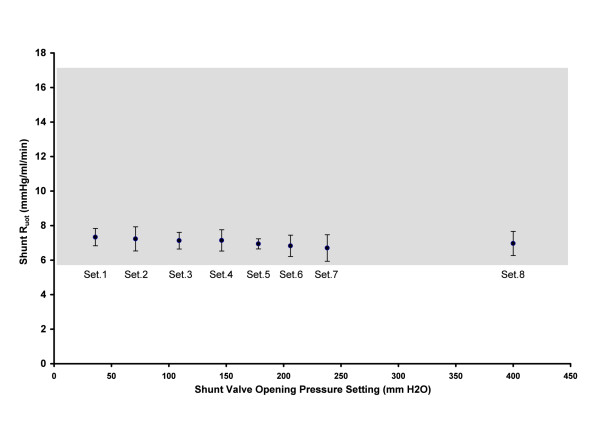
Shunt outflow resistance for six shunts at each of the 8 shunt settings (shown in the labels). Error bars show the 95% confidence limits. The shaded area shows the reference range (10th to 90th percentile) of Rout for healthy elderly [6].